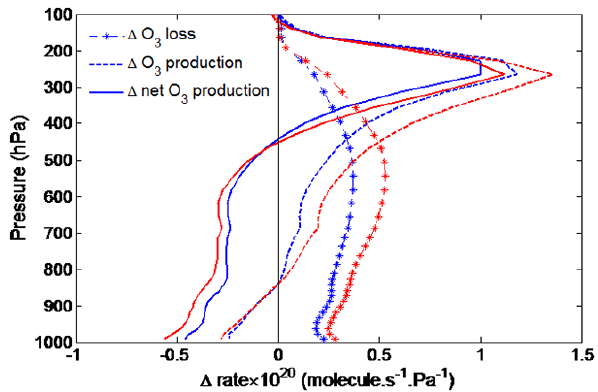
Figure 5. Vertical profile describing the aviation NO x -induced change in the rate of O 3 production with height (results are shown in red for CAM5 and in blue for CAM4). Net rate of ozone produc- tion (solid line), the gross rate of ozone production (dashed line), and the rate of ozone loss (dotted line) are shown. Production and loss rates are calculated as zonal and meridional